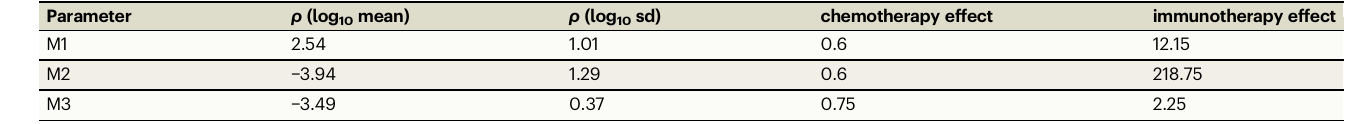
Table 3 | Fitted parameter values used in Fig. 5 – 7